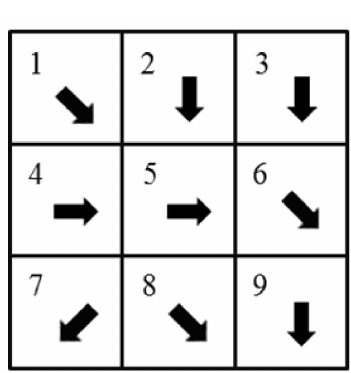
Figure 1. Drainage directions of grid-based dataset in quasi-2D routing